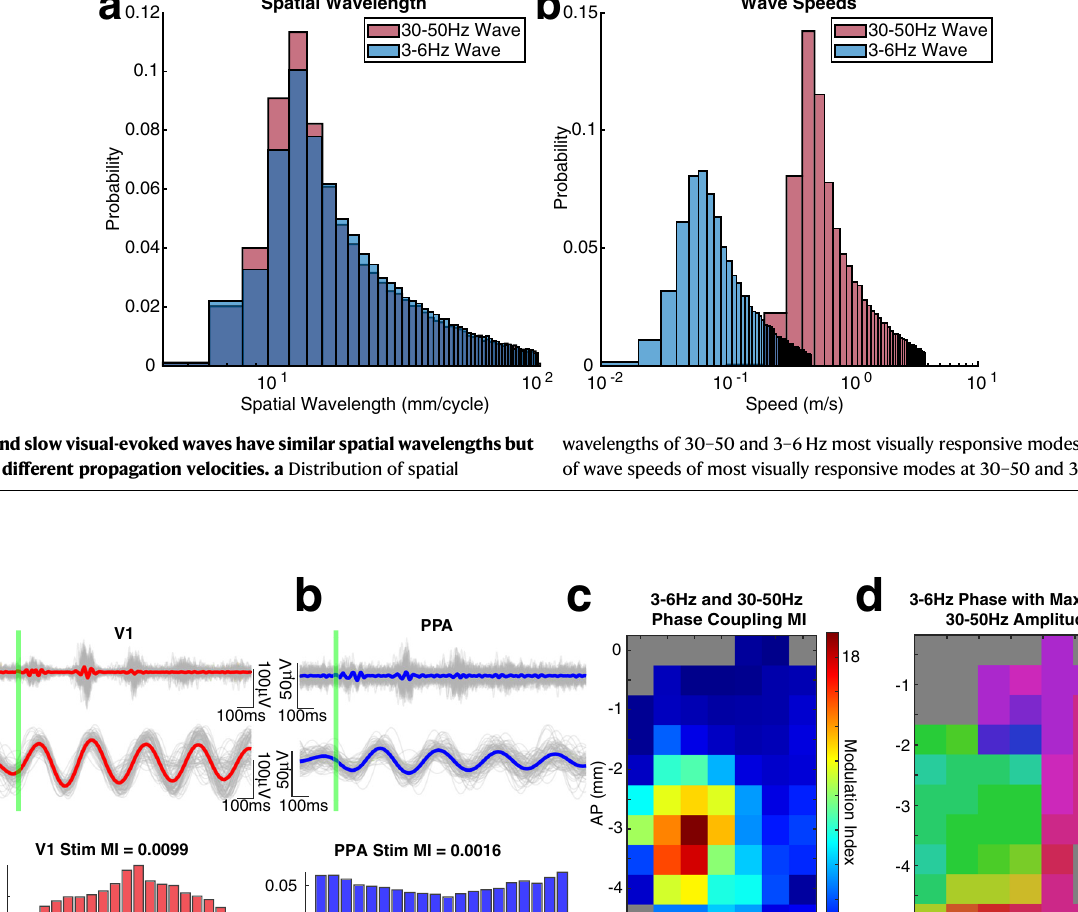
compared to time shuf fl ed surrogates). Note that the phase of the 3 – 6Hz oscillation at which the gamma amplitude is maximum is shifted compared to thatinV1. c Modulationindicesaveragedoverall13miceandplottedincolorat each stereotaxic location. Locations that are grayed out did not meet Bonfer- roni corrected statistical signi fi cance ( p value< 0.0006, Rayleigh test) com- pared to time shifted surrogate data. MI peaks near V1 but remains statistically signi fi cant over much of the cortical surface. d The phase of the slow 3 – 6Hz oscillation at which the fast 30 – 50Hz oscillation reaches maximum amplitude as shown for a representative mouse at each stereotaxic location. Grayed out locations did not meet statistical signi fi cance ( p value <0.0006, Rayleigh test) compared to time shifted surrogates.